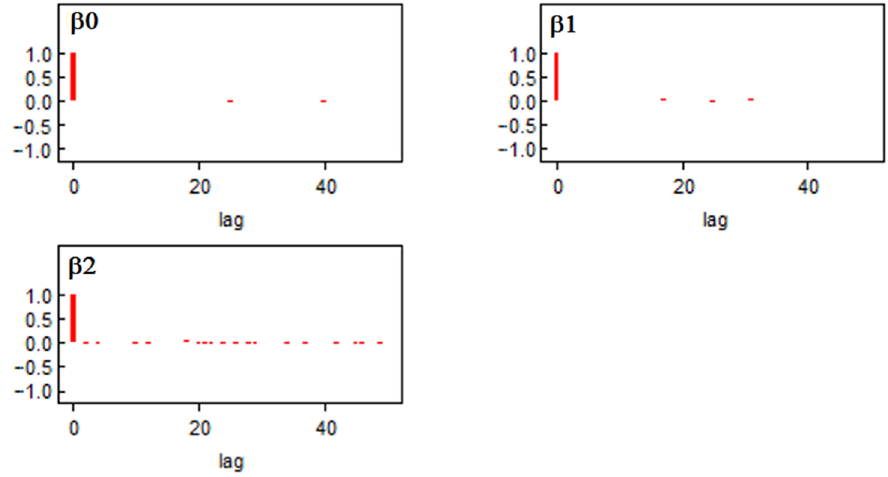
Figure 4. Autocorrelation plot of MCMC estimation.